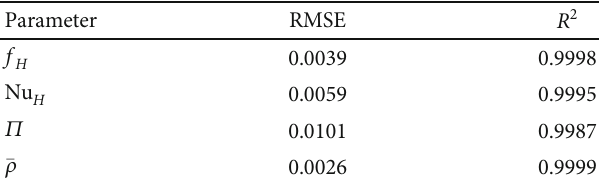
Table 4: Evaluation of RBF approximate models.